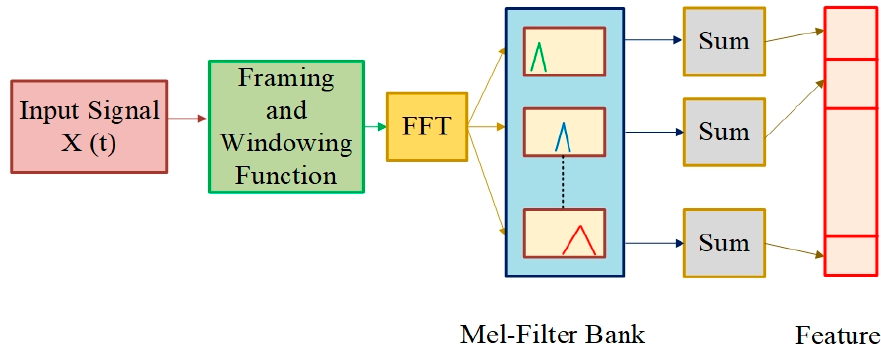
Figure 3. Evaluation of Mel-spectrogram .